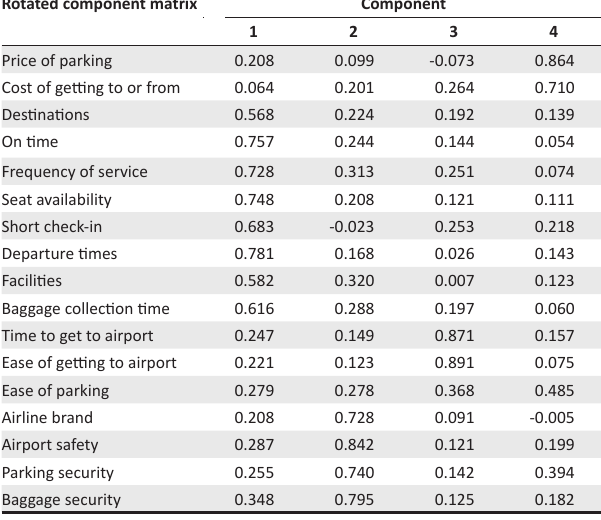
TABLE 4: Factor rotation – four factors (2013). Rotated component